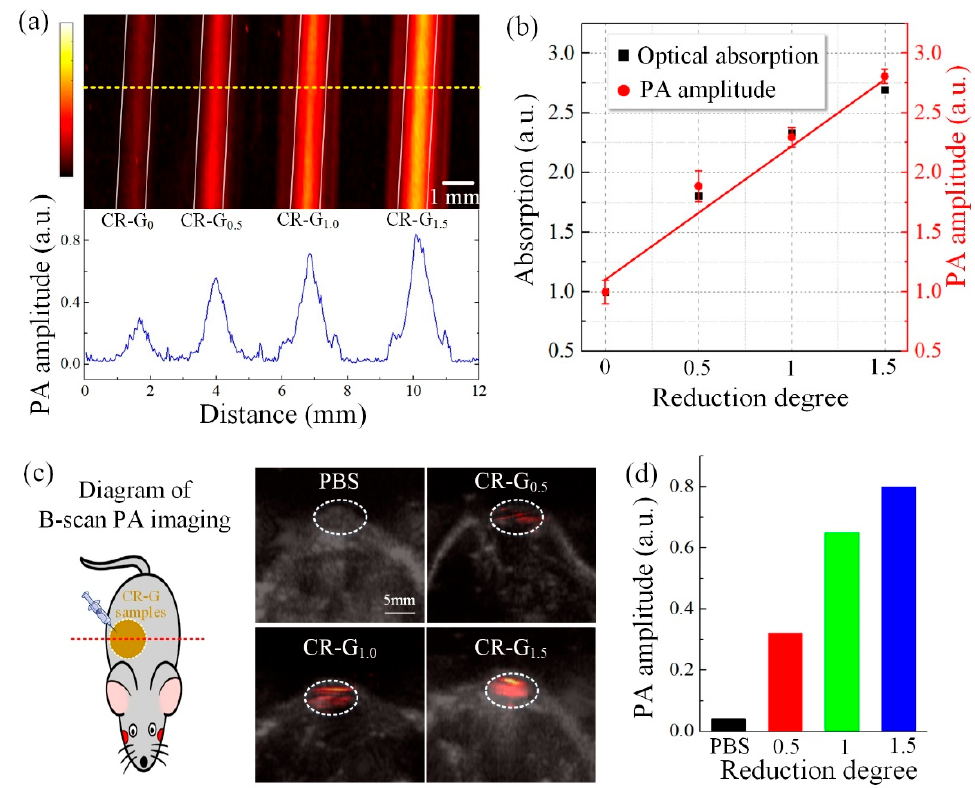
Figure 5. Photoacoustic (PA) characterization of the chemically-reduced graphene oxide (CR-G). ( a ) The in vitro PA imaging and signal amplitude profile of CR-G nanomaterials with different reduction degrees. The comparison of the optical absorption and the PA signal amplitudes of CR-G nanomaterials with different reduction degrees in NIR-II region. ( b ) The statistical analysis of the obtained PA signal amplitudes with the reduction degrees ( a ). ( c ) B-scan in vivo PA imaging overlaid ultrasound imaging for the mouse model injected with CR-G nanomaterials with different reduction degrees in NIR-II region. ( d ) The statistical analysis of the obtained PA signal amplitudes with the reduction degrees ( c ).